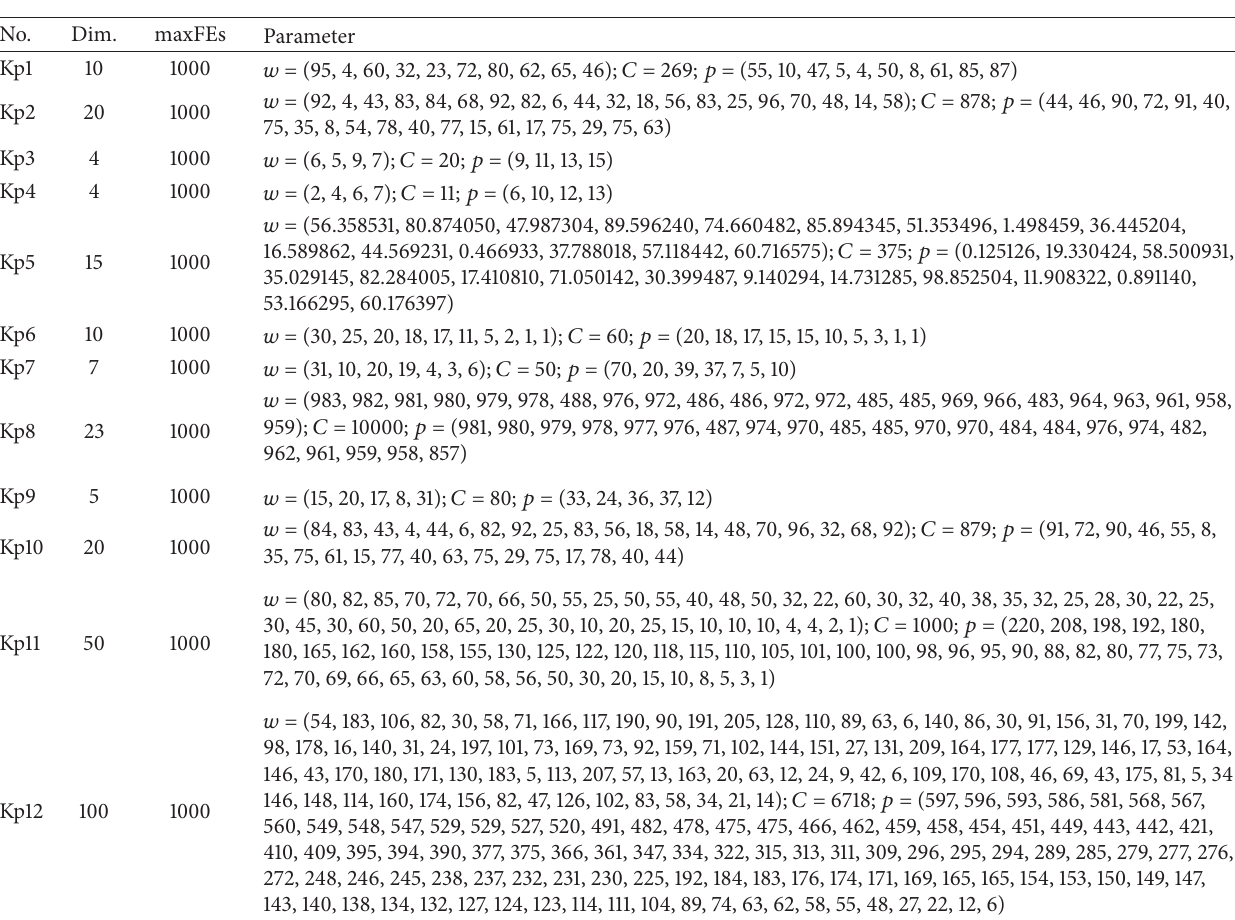
Table 1: The dimensions and parameters of the twelve test